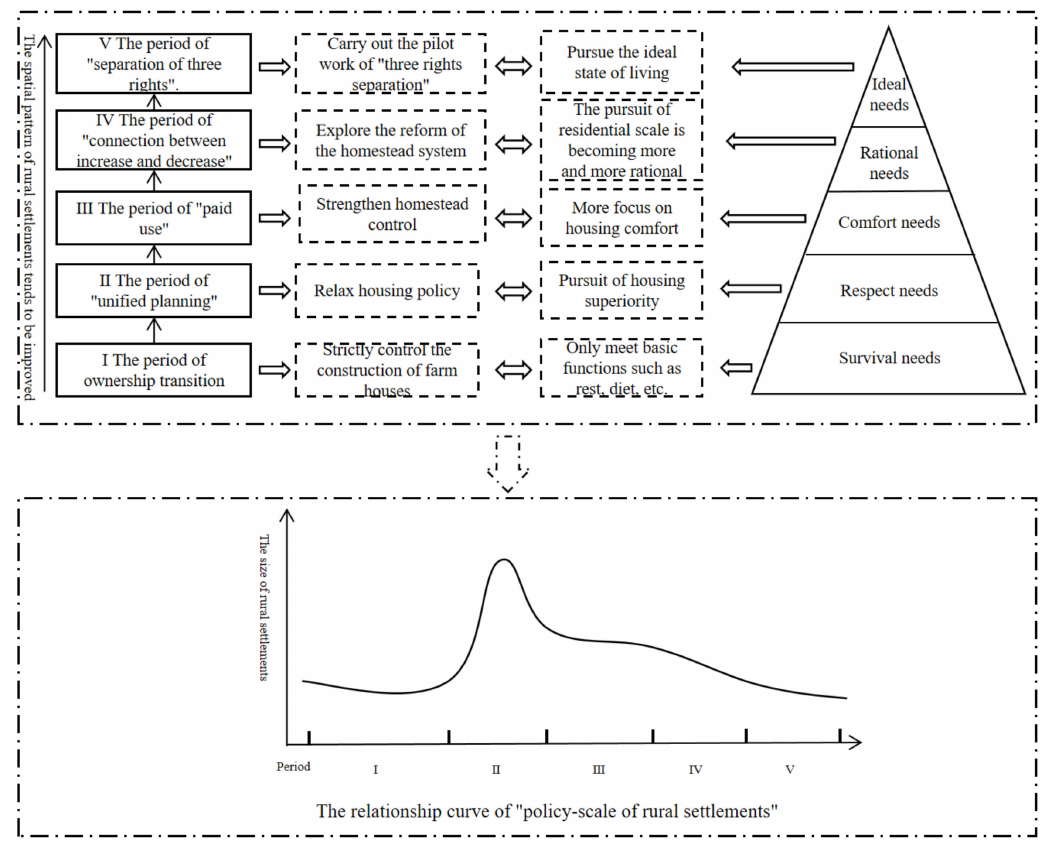
Figure 2. Theoretical